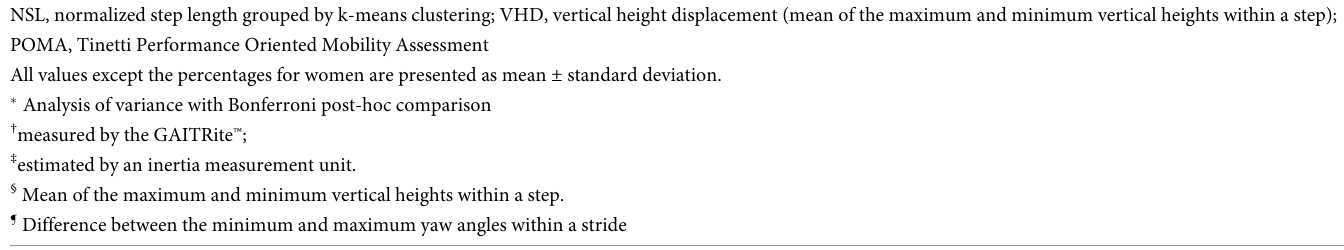
Table 2. For all the regression models, only the features with a variation inflation factor (VIF) below 2.5 were included.